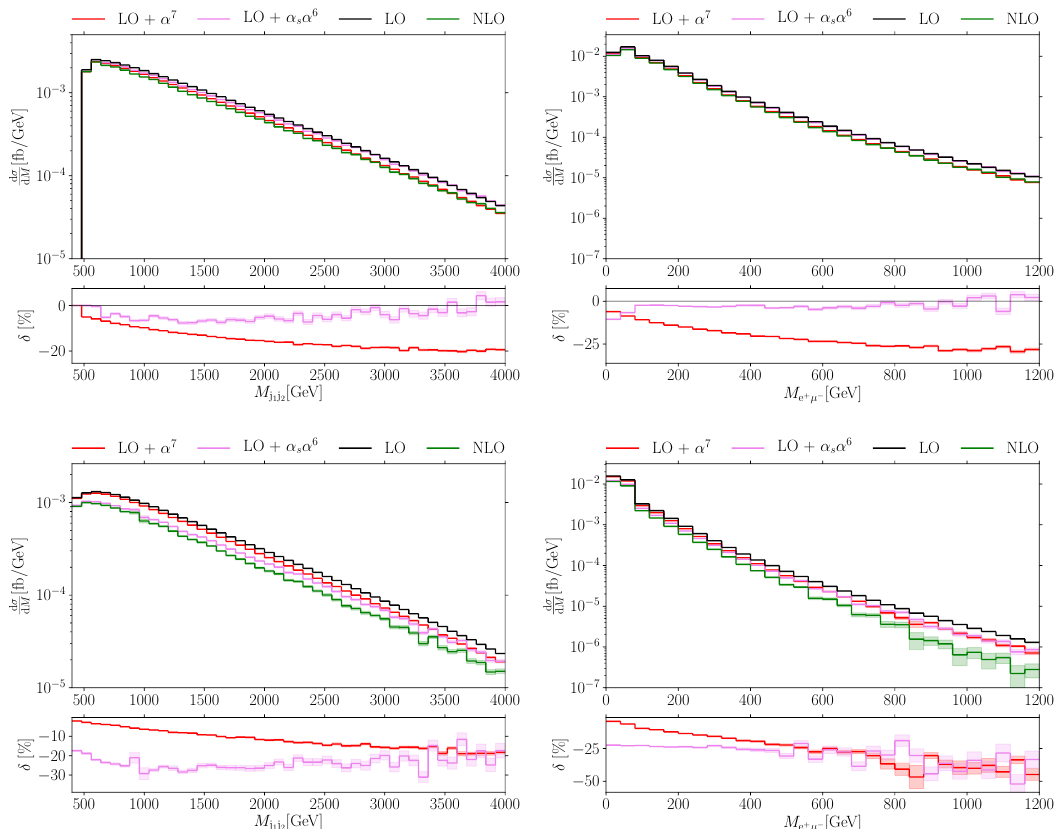
Figure 10. Differential distributions at NLO in the invariant mass of the two tagging jets (left) and the charged leptons (right) in the VBS (top) and the Higgs setup (bottom). The upper panels show (cid:0) (cid:1) the absolute EW contribution at α 6 , the sum of the EW contribution and the EW corrections O (cid:0) (cid:1) of α 7 , the sum of the EW contribution and the QCD corrections of O three contributions. The lower panels show the relative EW and QCD corrections normalised to the LO EW contribution. Shaded bands denote integration